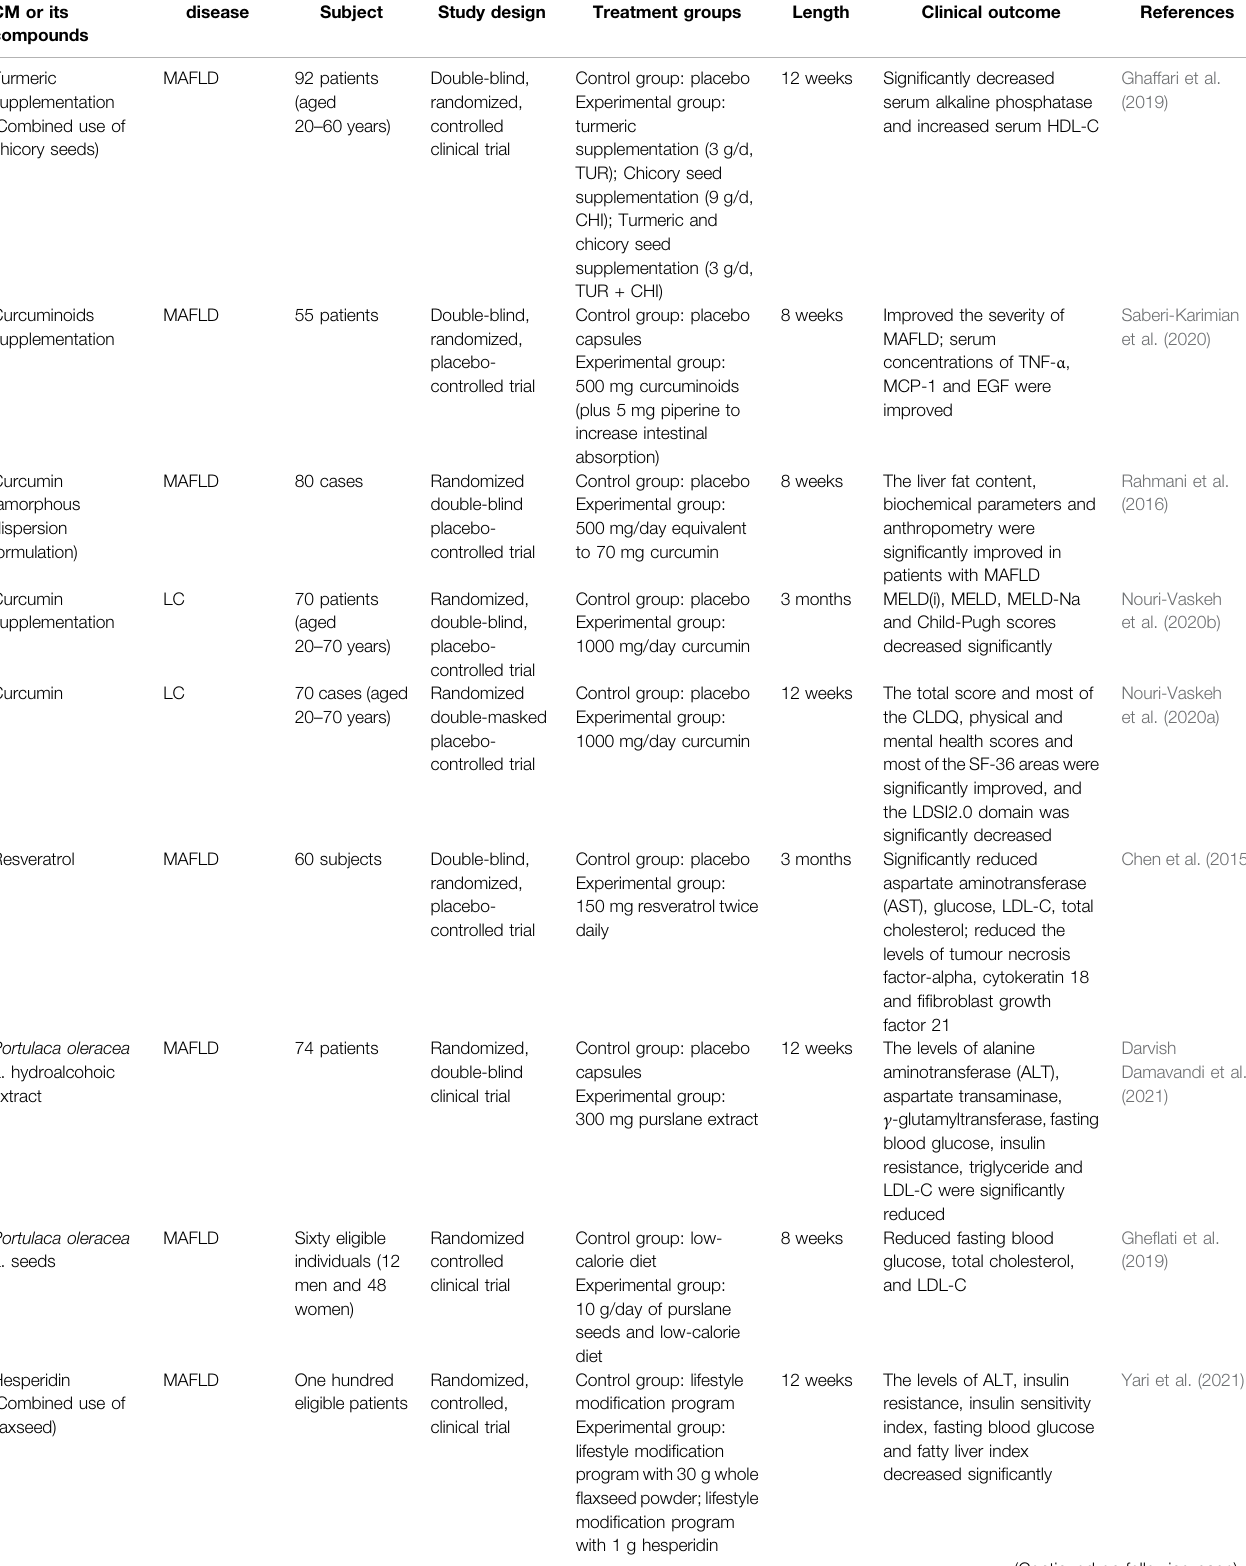
TABLE 7 | Some Chinese medicine are used to treat liver diseases in